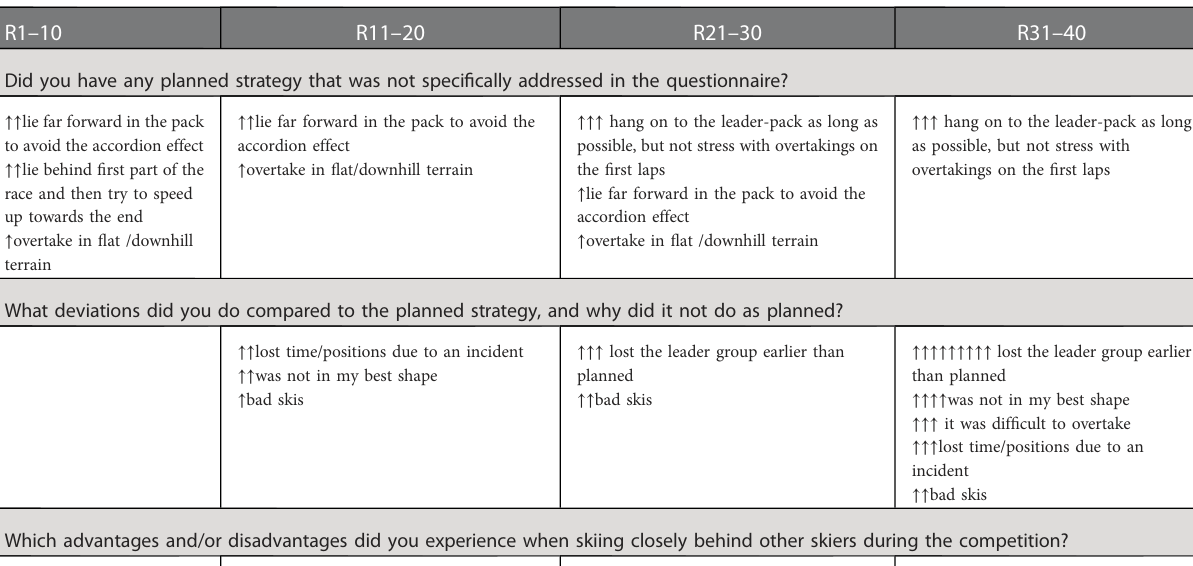
TABLE 4 Summary of encoded statements from the skiers ( ↑ illustrates the number of skiers) to the open questions in the questionnaire fi lled out after a 21.8 km mass-start competition in cross-country skiing, divided into different